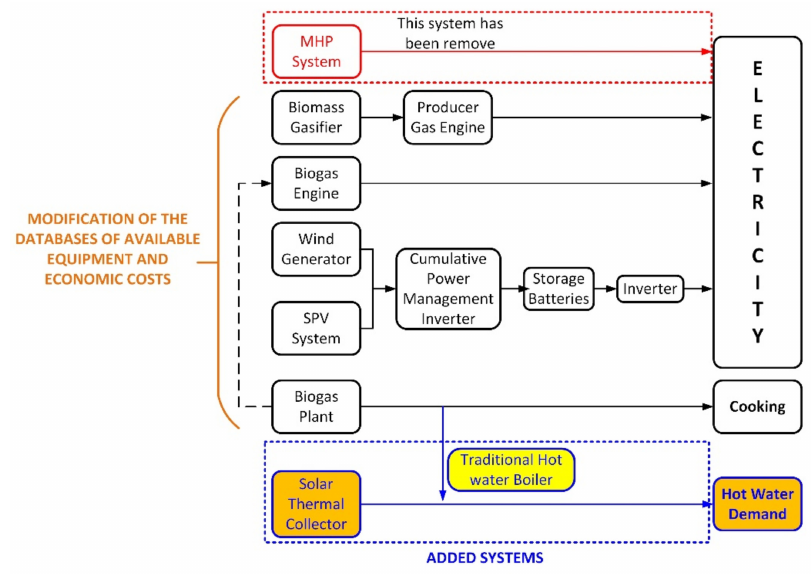
Figure 7. Configuration of the modified IREOM